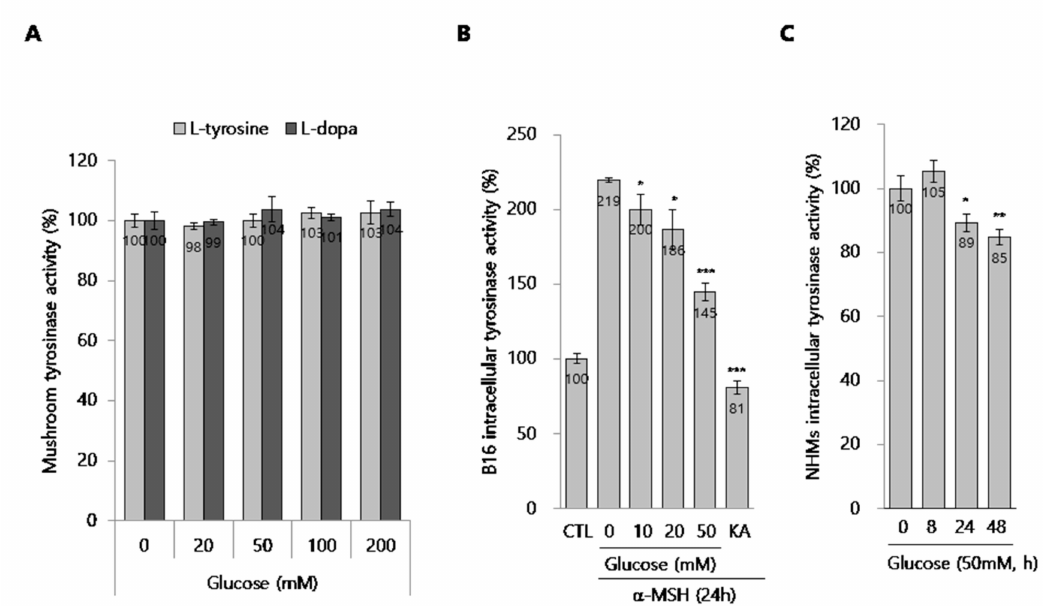
Figure 4. E ff ect of glucose on the tyrosinase activity. ( A ) E ff ect of glucose on the mushroom tyrosinase activity in cell-free system. ( B , C ) Cellular tyrosinase activity assay. ( B ) B16 cells were treated with the indicated concentrations of glucose for 24 h. Then, the cellular tyrosinase activity assay was performed, as described in the methods section. ( C ) NHMs were treated with 50 mM glucose for the indicated time. Then, the cellular tyrosinase activity assay was performed, as described in the methods section. The cellular tyrosinase activity was normalized by the total protein contents. Data are expressed as the mean ± SD of at least three independent measurements (* p < 0.05, ** p < 0.01, *** p <